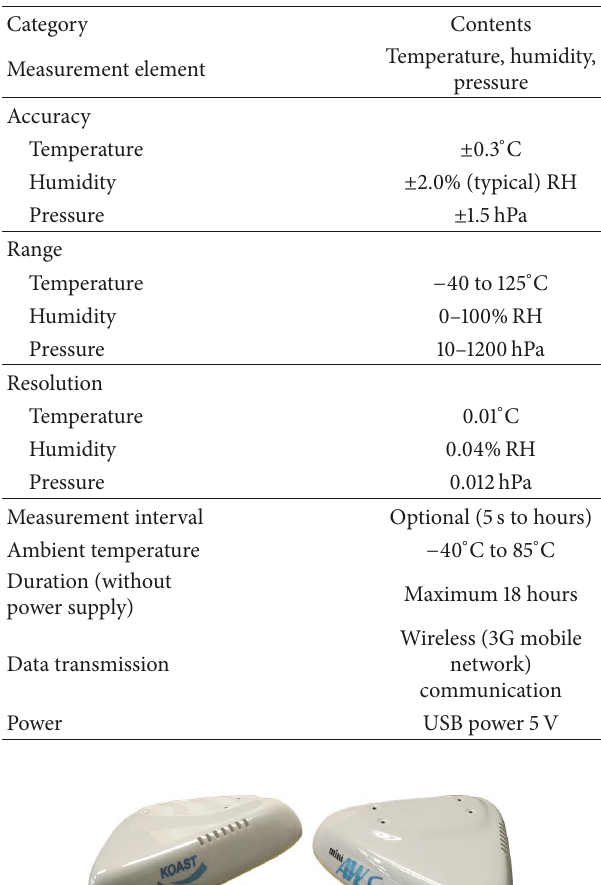
Table 1: Specifications of the Mini-AWS.